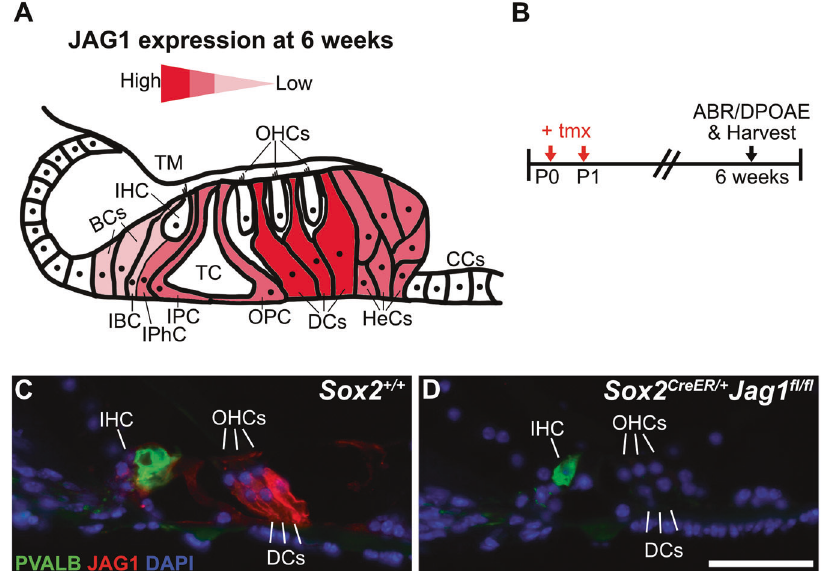
Fig. 1 Deletion of the Notch ligand JAG1 in maturing supporting cells results in undetectable JAG1 immunostaining at 6 weeks. A Drawing of a cross-section through the adult organ of Corti showing JAG1 expression in supporting cells at 6 weeks of age. B Offspring from Sox2 CreER/ + Jag + / fl x Jag1 fl / fl matings were administered tamoxifen ( + tmx) at postnatal days (P)0 and P1; hearing was analyzed and cochleae were harvested at 6 weeks. C , D Paraf fi n sections through 6-week-old cochlea stained for hair cells (PVALB), nuclei (DAPI) and JAG1. Scale bar: 50 µm. C Sox2 + / + littermate control showing the normal expression of JAG1 in Deiters ’ cells, inner phalangeal cells, and pillar cells, which is largely undetectable in Sox2 CreER/ + Jag1 fl / fl mutant cochleae ( D